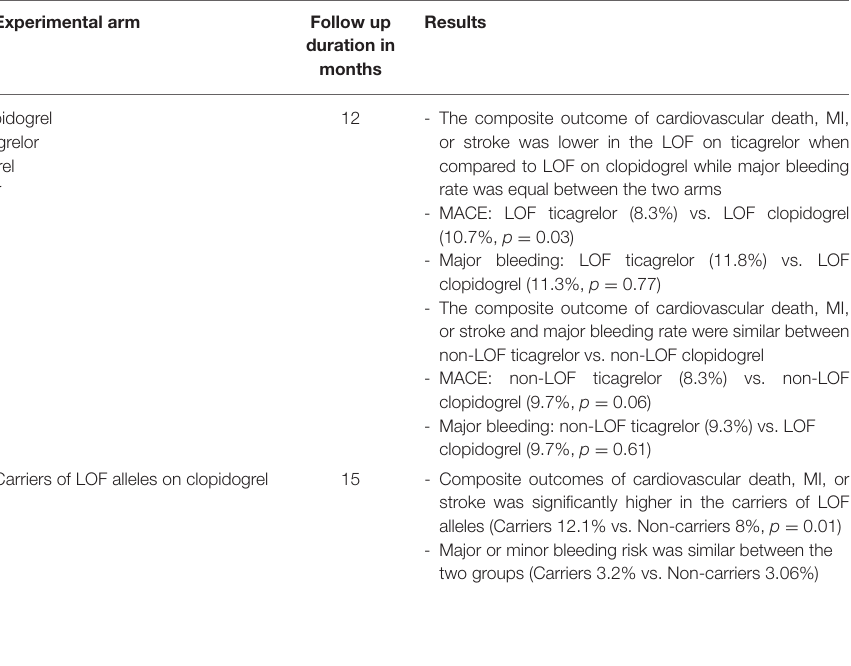
two groups (Carriers 3.2% vs. Non-carriers